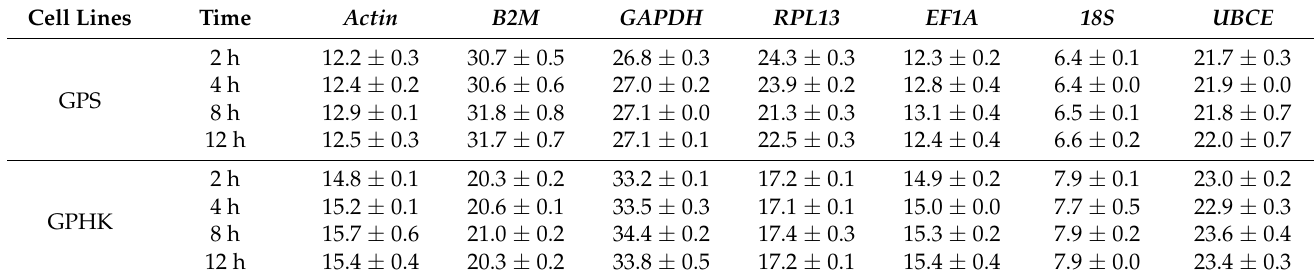
Table 2. Expression abundance of seven housekeeping genes among GPS and GPHK cells under normal conditions for 2, 4, 8 and 12 h. Values are shown as means ± SD ( n =